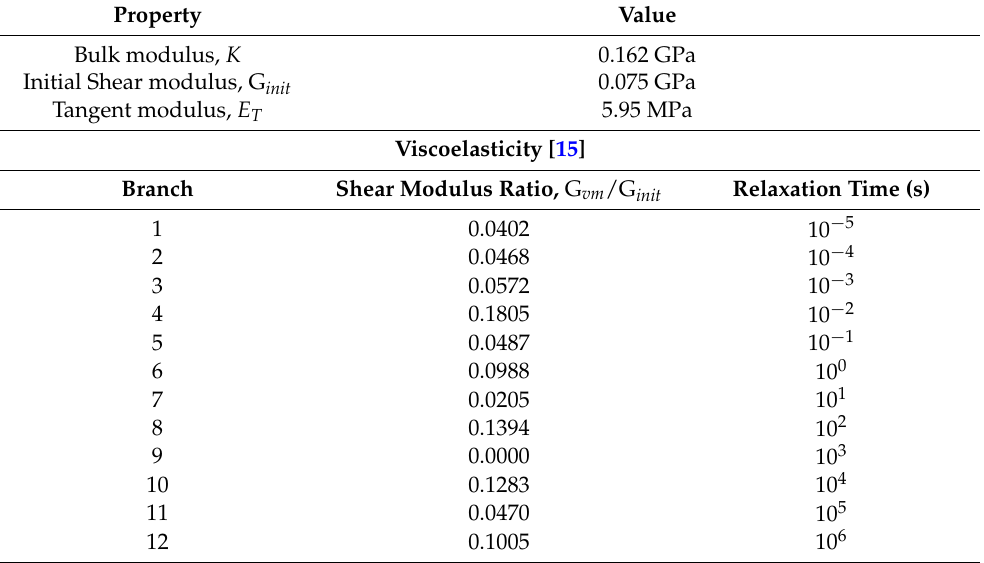
Table 1. Material properties of dense PET used in finite element model.